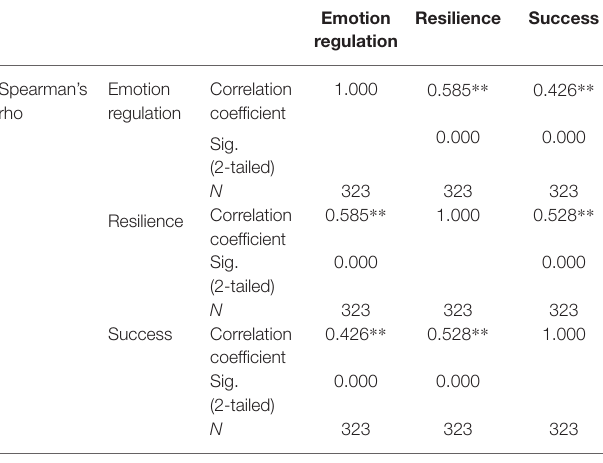
TABLE 4 | Correlation among emotion regulation, resilience, and success.